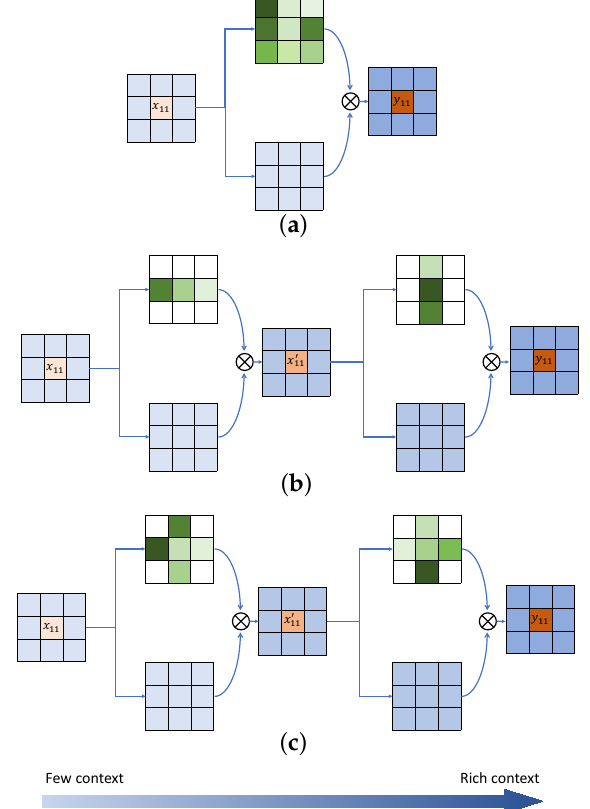
Figure 4. Implementation of different attention mechanisms. ( a ) is non-local attention. ( b ) is axial attention. ( c ) is criss-cross attention.